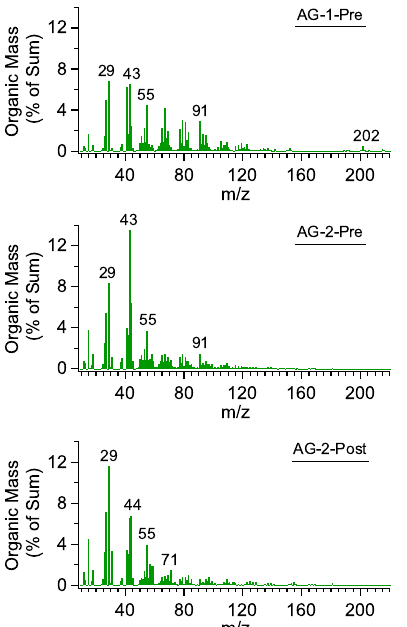
Figure 7. Organic mass spectra of SOA produced from the first Abies grandis pre-treatment experiment (AG-1-Pre), the second Abies grandis pre-treatment experiment (AG-2-Pre), and the sec- ond Abies grandis post-treatment experiment (AG-2-Post). The AG- 1-Pre spectrum represents a naturally elicited stress condition, the AG-2-Pre spectrum represents a typical baseline condition, and the AG-2-Post represents a typical post-treatment condition after MeJA plant hormone application.